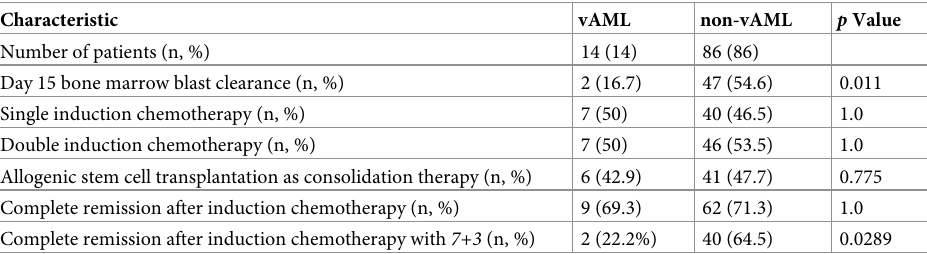
Table 5. Clinical findings.